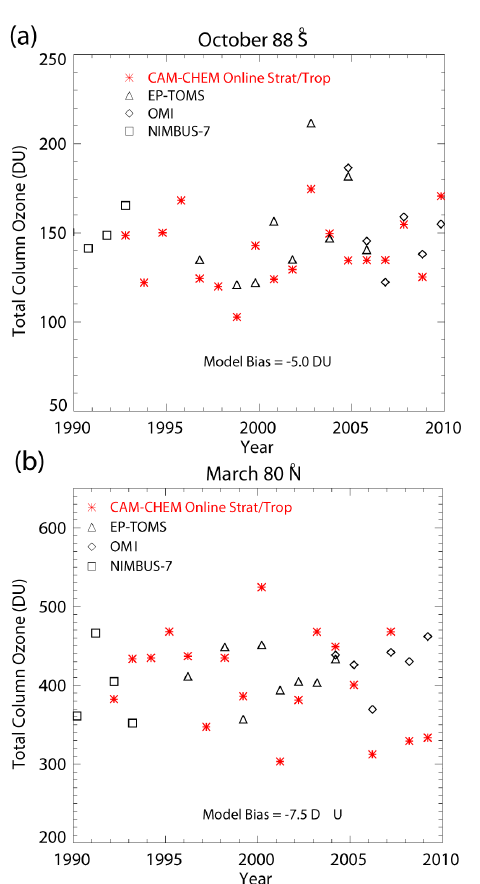
Fig. 13. Time evolution of zonally and monthly-averaged total ozone column (in Dobson Units) from satellite measurements (EP- TOMS and OMI, top) and online simulation (bottom).